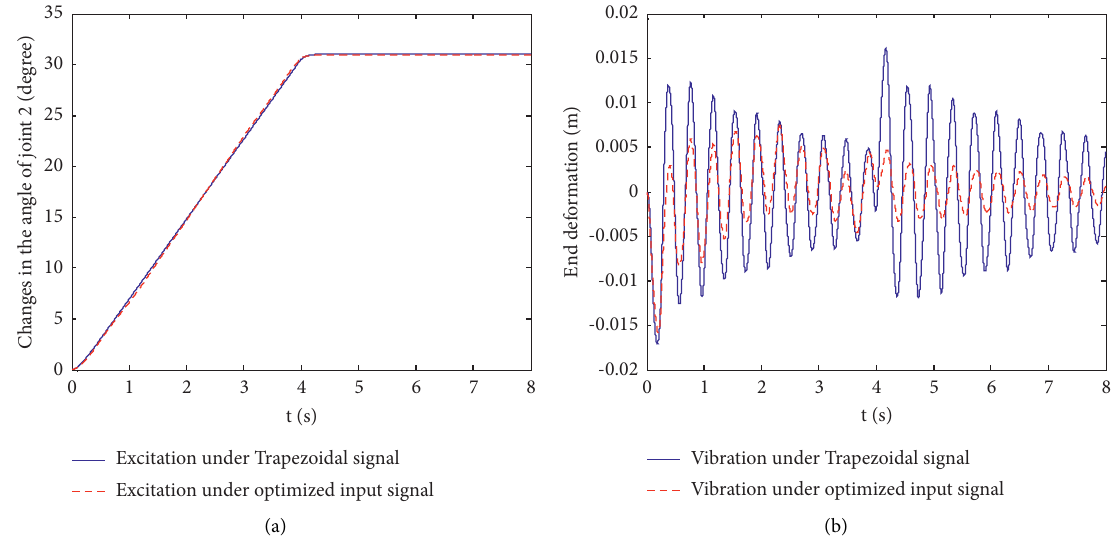
Figure 13: Comparison of end angle and end vibration: (a) end angle; (b) end